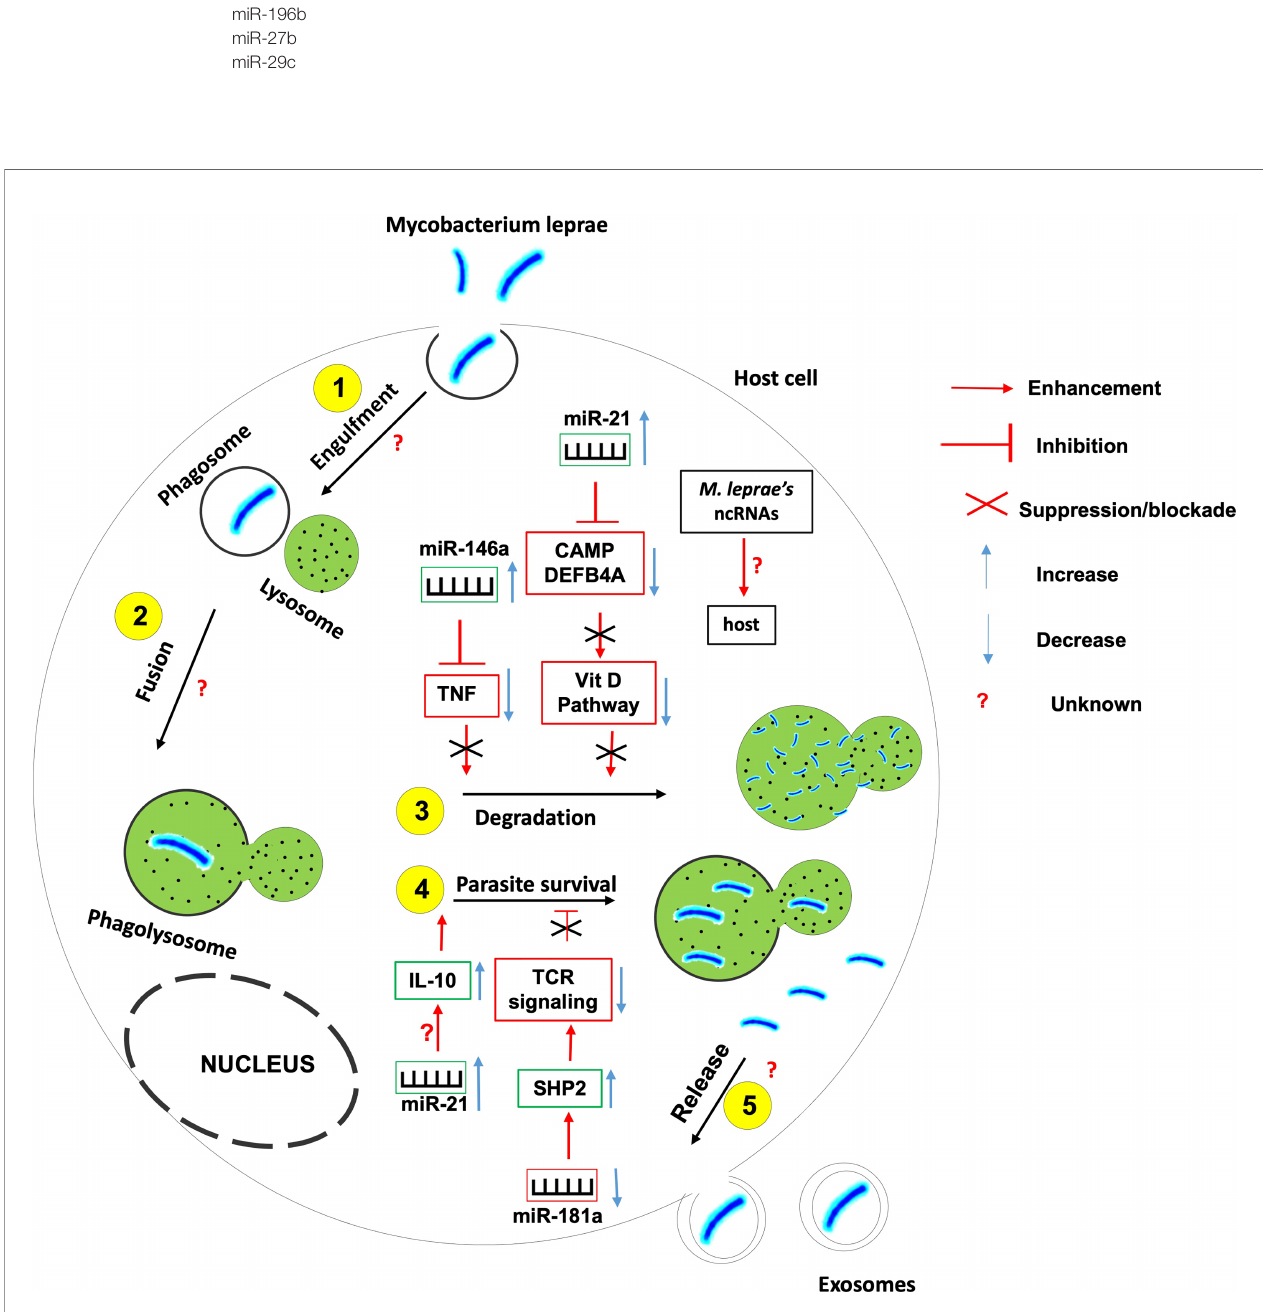
FIGURE 5 | The role of non-coding RNAs in the etiology of leprosy. Several ncRNAs are found to be instrumental in the induction or inhibition of the host effector killing functions against Mycobacterium leprae. More research needed to identify 1- host ncRNAs that regulate the parasite entry within the host, its engulfment within phagosome and the fusion between phagosome and lysosomes; 2- the role of M. leprae-derived ncRNAs on the outcome of mycobacterium-macrophage interaction.